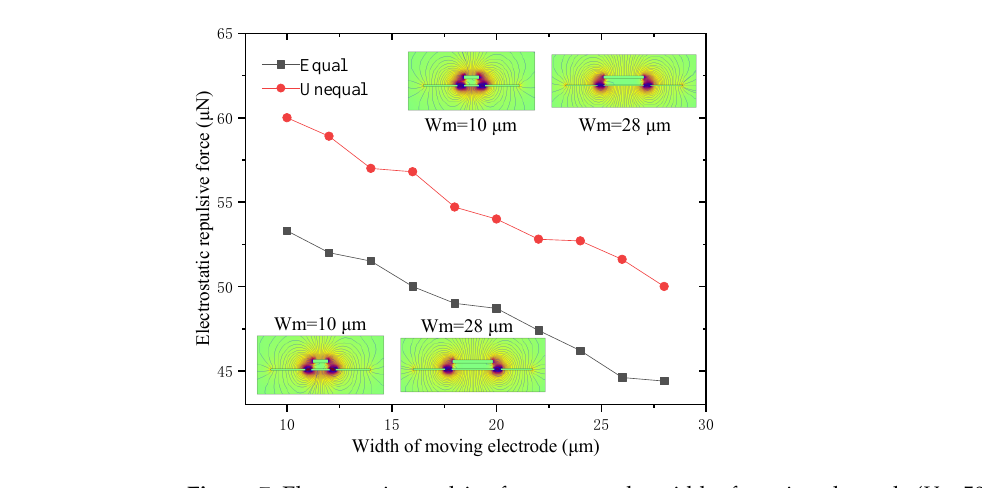
Figure 7. Electrostatic repulsive force versus the width of moving electrode ( V = 500 V, d 1 = d 2 = 4 µ m, W f = 22 µ m and h m = 2 µ m).